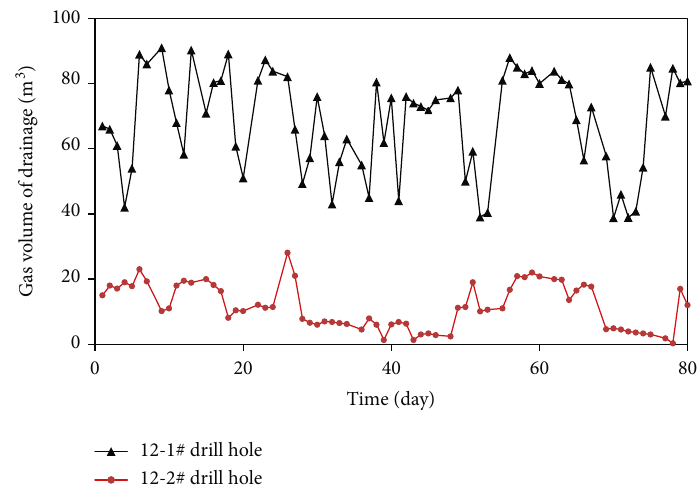
Figure 17: Gas extraction in the borehole group 12#.